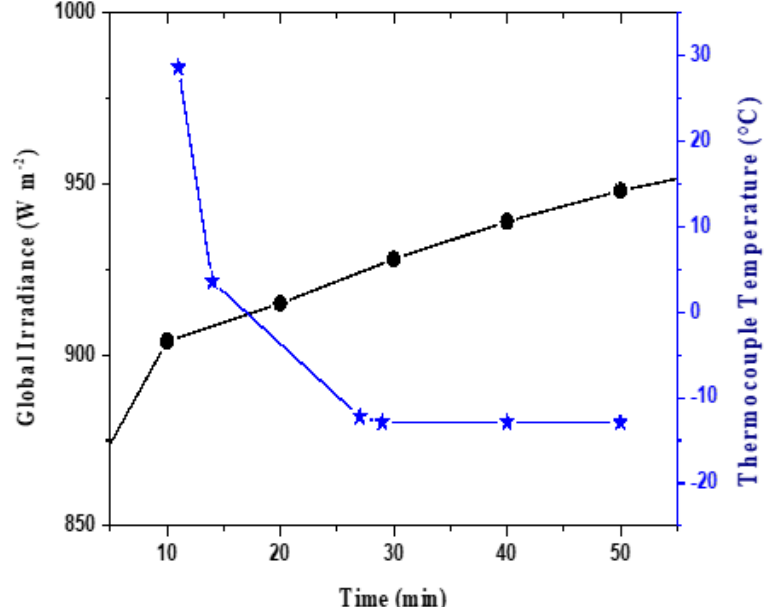
Figure 8. Experimental characterization of the radiative cooler prototype on the roof: first experimental test.